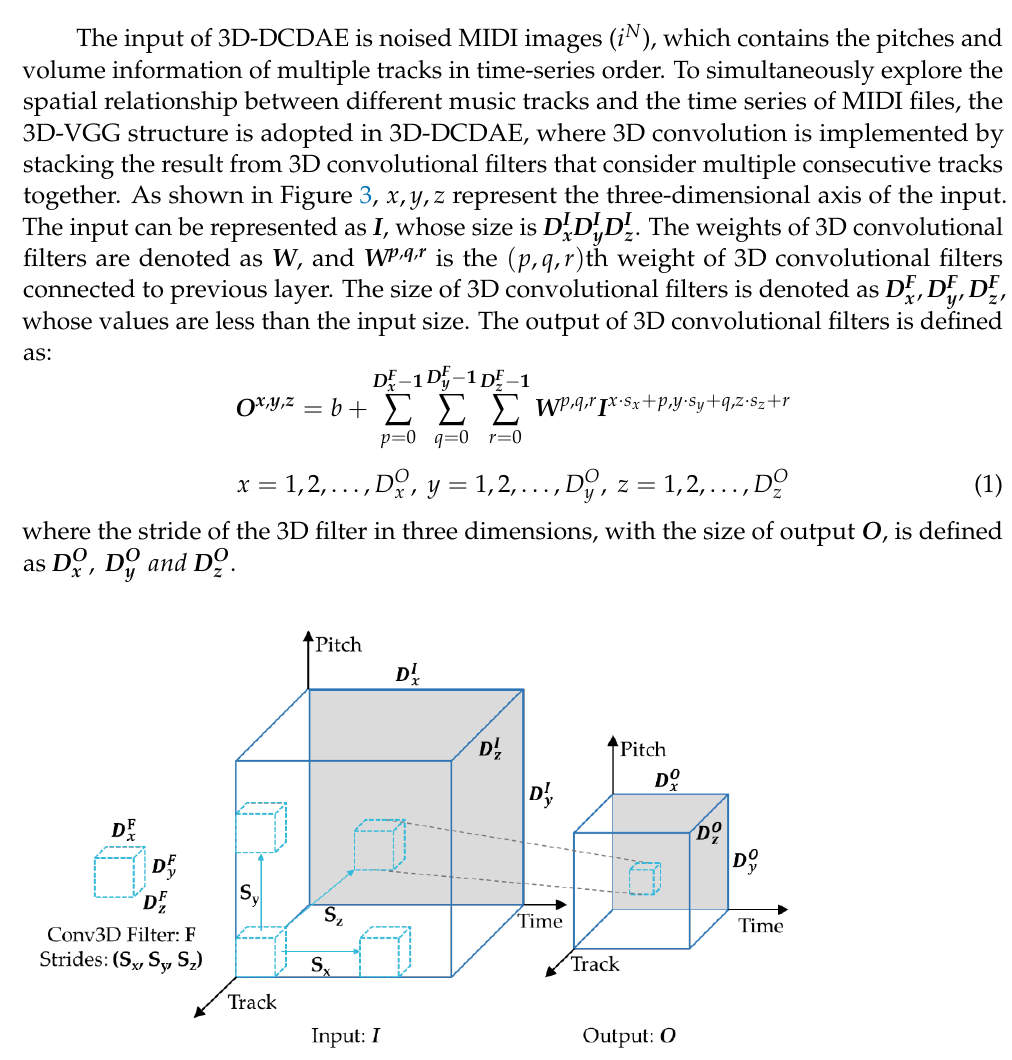
Figure 2. Structure of 3D-DCDAE.